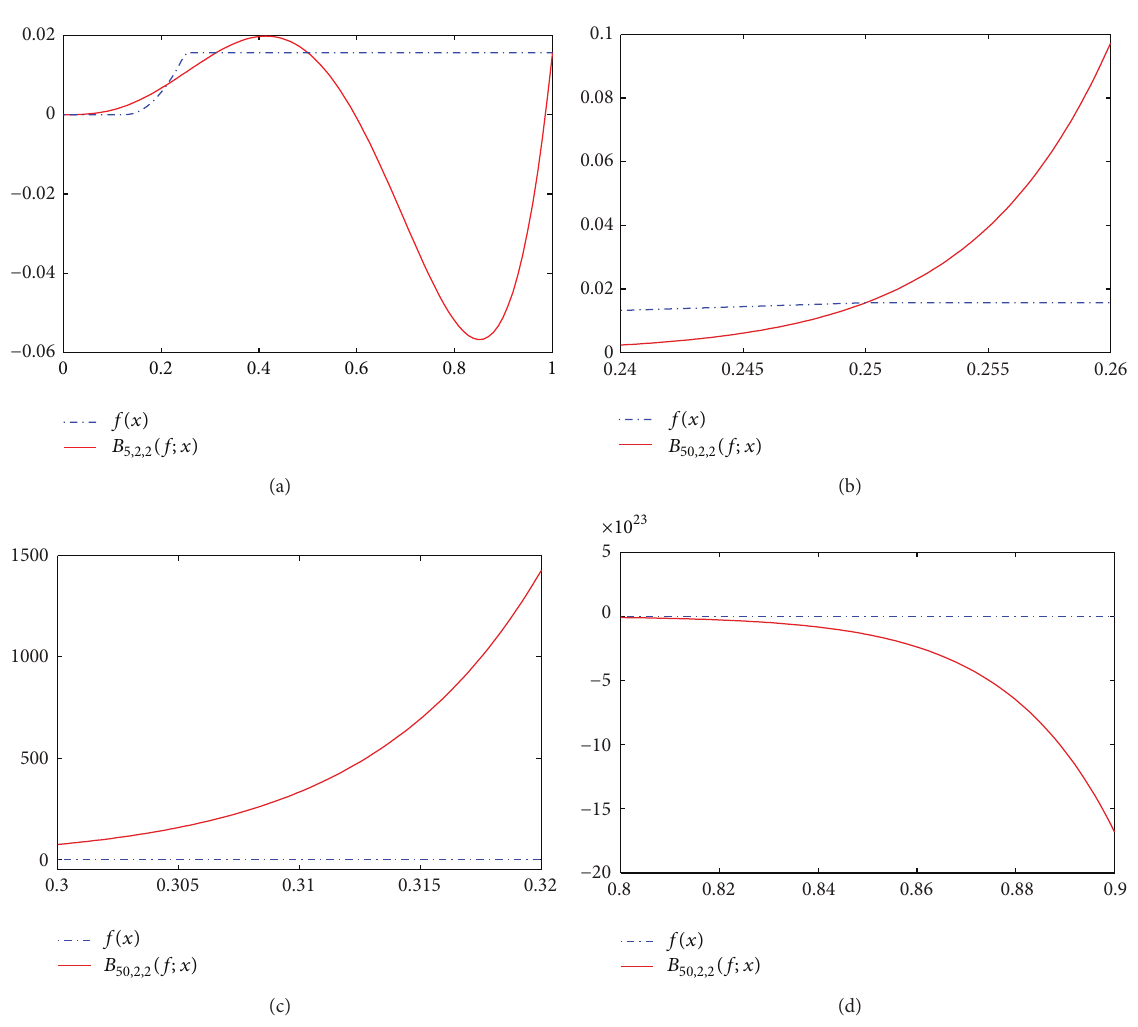
Figure 1: Graphs of 𝑓 and 𝐵 𝑛,2,2 (𝑓) on different intervals for some values of 𝑛